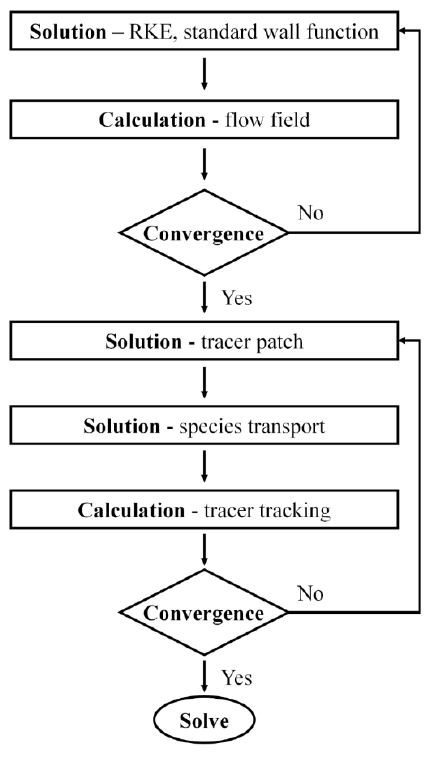
Figure 3. Flow chart of convergence cycle used in the simulation.